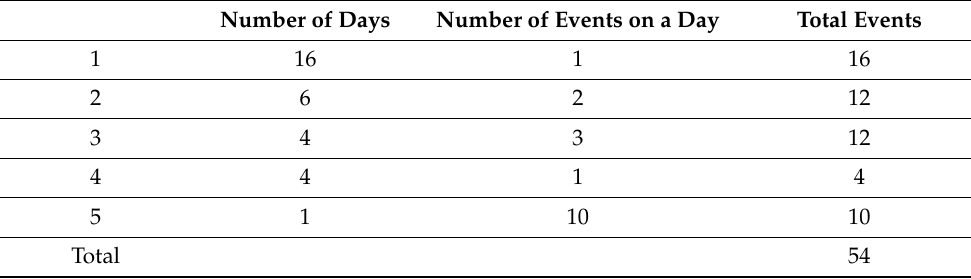
Table 8. Number of days and number of events on each